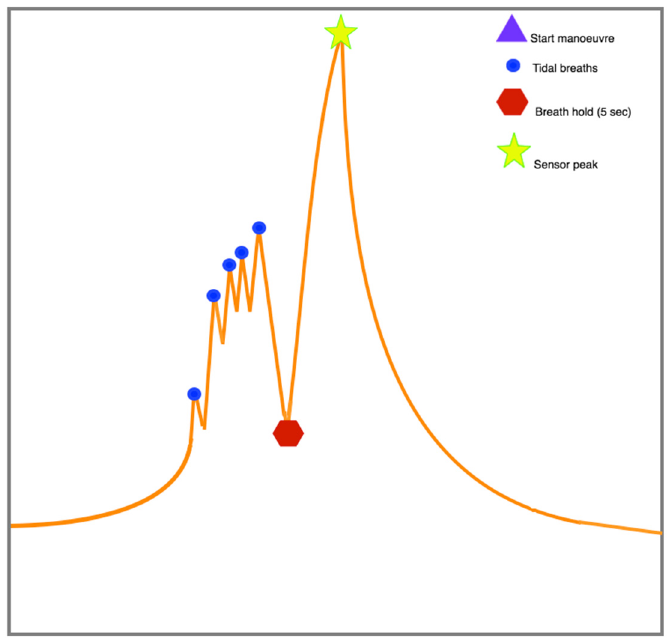
Figure 2. eNose maneuver. Adapted from Mahmoud I. Abdel-Aziz et al. [40].